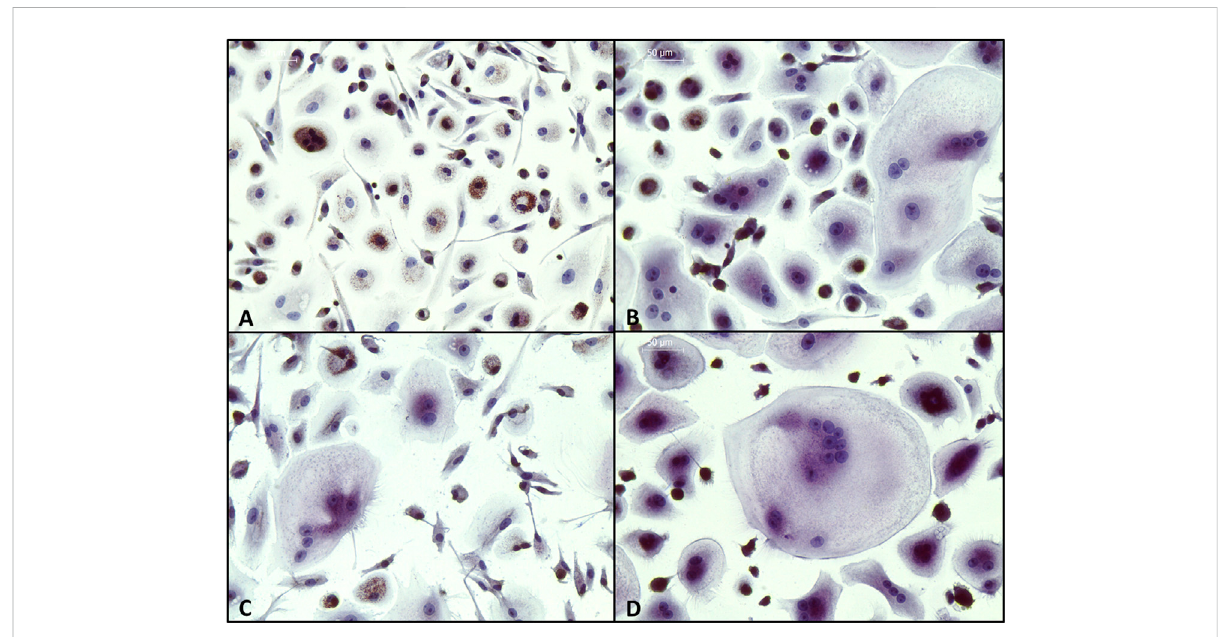
FIGURE 12 Detection of tartrate-resistant acid phosphatase (TRAP) in PBMCs. Cells were incubated (A) with M-CSF (negative control); (B) with M-CSF + RANKL(positivecontrol);(C)withM-CSF+RANKL+secretome(10x)ofJPCsincubatedwithosteogenicmediumwithoutdexa(JPC_OB-D);(D)with secretome (10x) of JPCs incubated with osteogenic medium with dexa (JPC_OB+D). Cells were incubated with different media supplementations for 8 days and then fi xed and stained for TRAP (purple) and nuclei (blue). (Scale bars = 50 μ